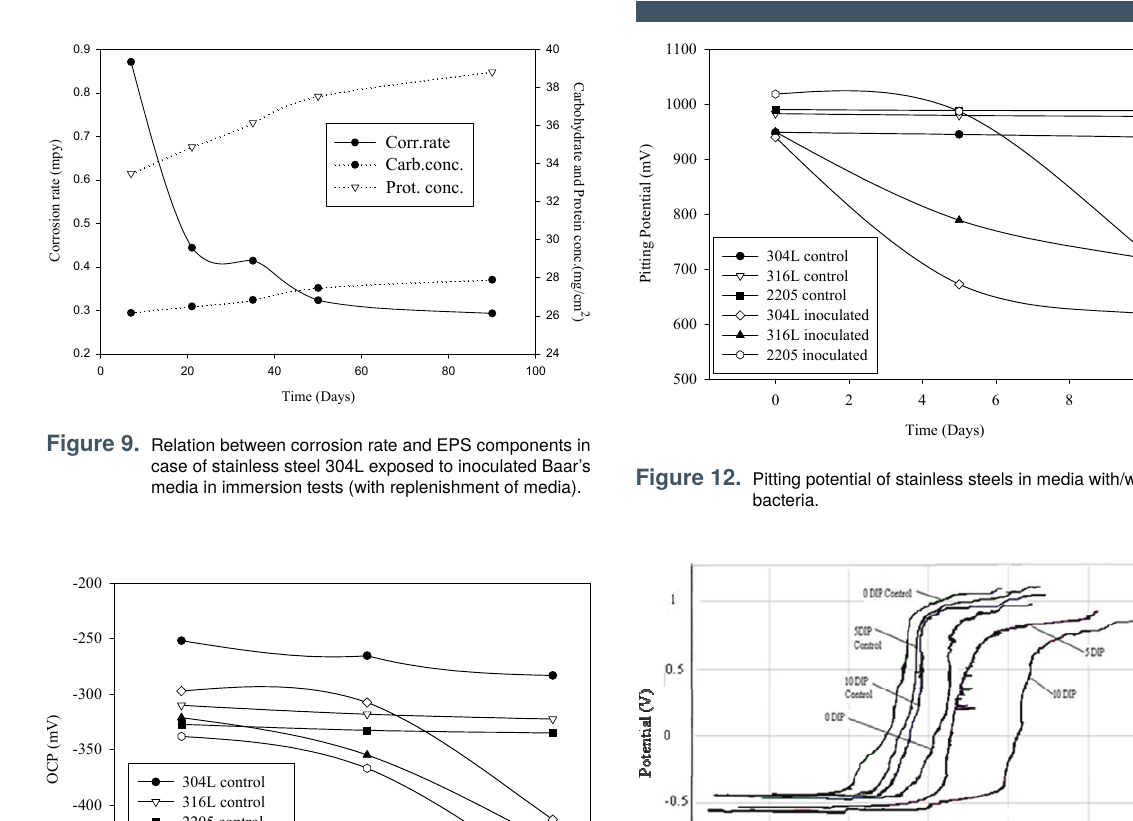
bacteriaTime Fig. 11 Passivation range of stainless steels in media with/without